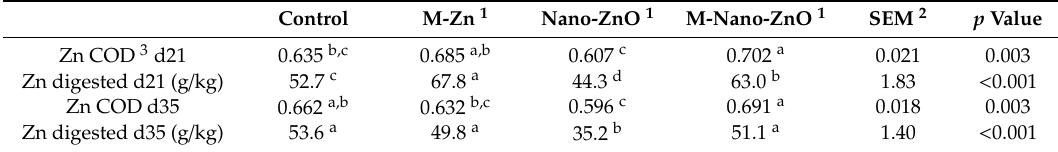
Table 2. E ff ect of zinc type on zinc digested and coe ffi cient of zinc digestibility of broilers.